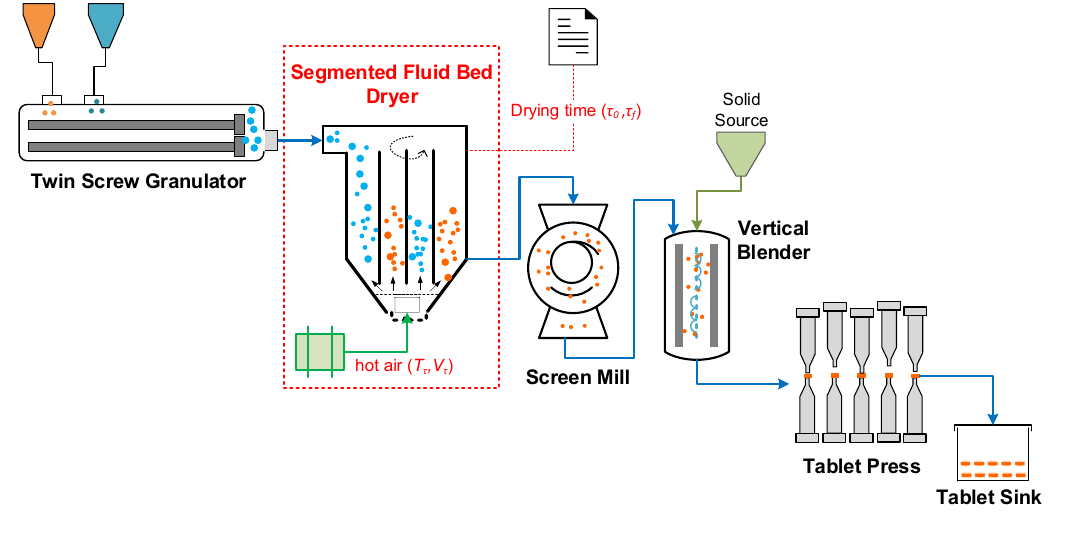
Figure 1. Flowsheet of continuous pharmaceutical process of tableting process (DiPP pilot